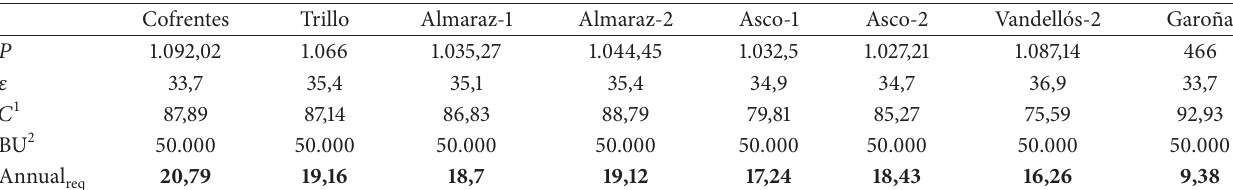
Table 2: Parameters of the nuclear